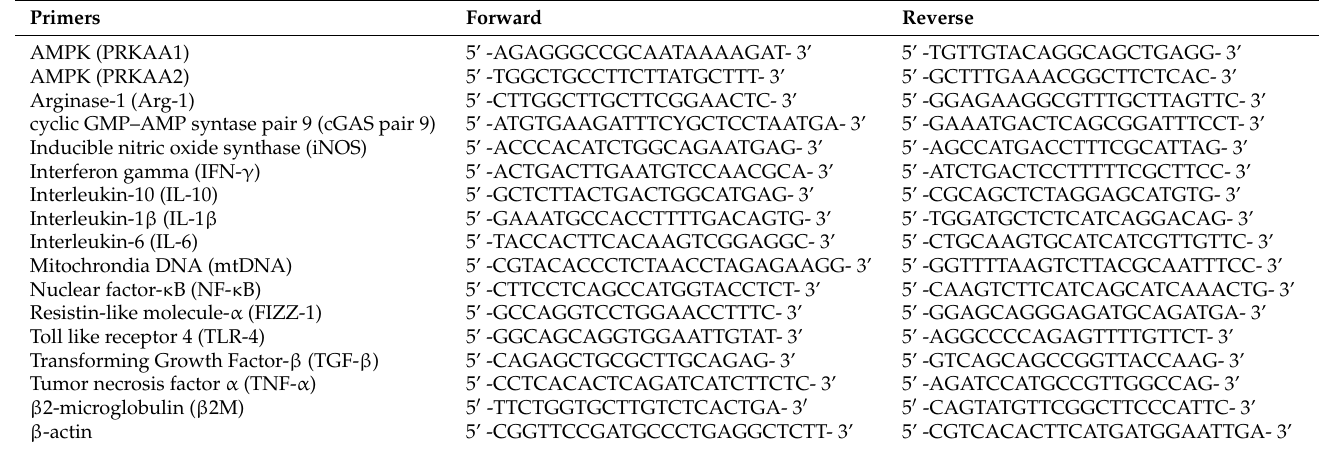
Table 1. List of primers used in the